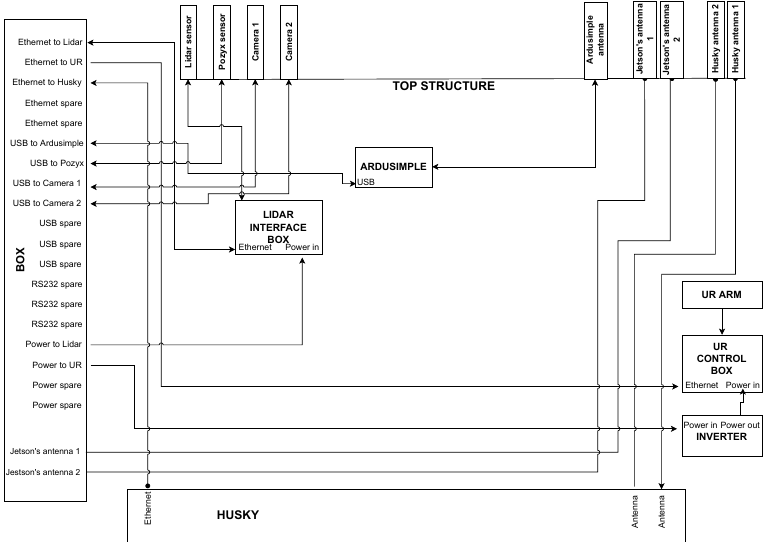
Figure 2. The design concept of the reconfigurable unmanned ground vehicle (UGV).